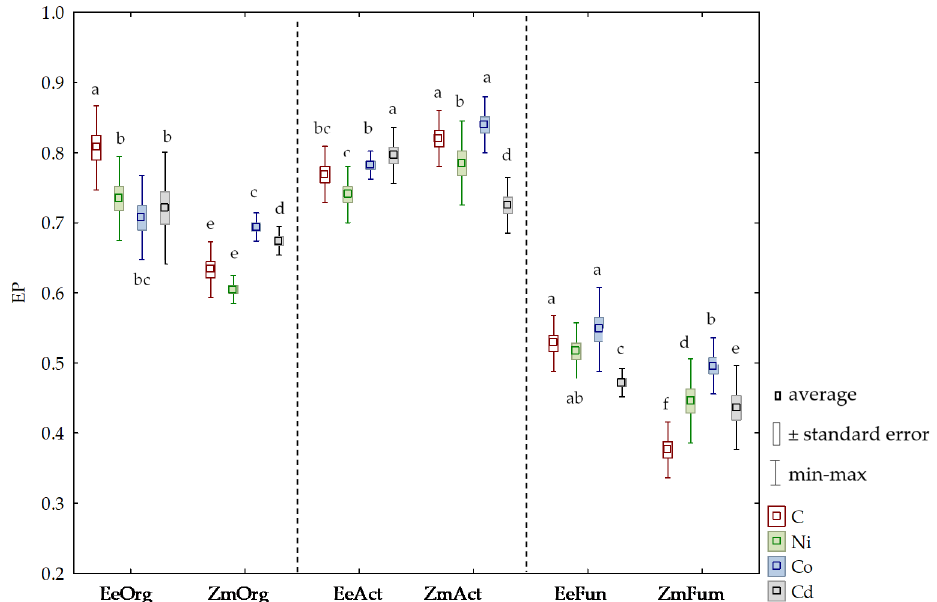
Figure 4. Microbial ecophysiological diversity index (EP) in the soil polluted with heavy metals. In general, high EP values were noted for actinobacteria and organotrophic bacteria, and lower ones for fungi. In the soil remediated with Elymus elongatus L., all heavy metals decreased EP of organotrophic bacteria, whereas Cd 2+ additionally decreased EP of fungi. Cd 2+ also adversely affected EP of actinobacteria in the soil sown with Zea mays